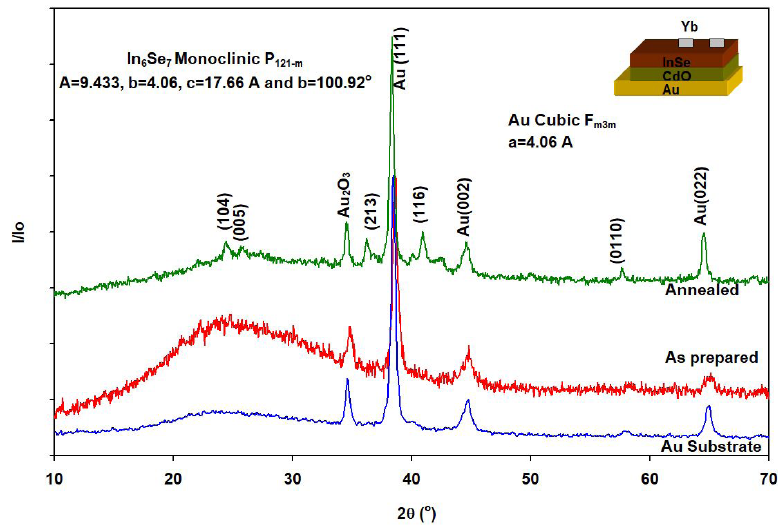
Figure 1. the X-ray diffraction patterns for Au, as prepared Au/CdO/InSe and for the annealed Au/CdO/InSe thin film transistors. The inset shows the geometrical design of the